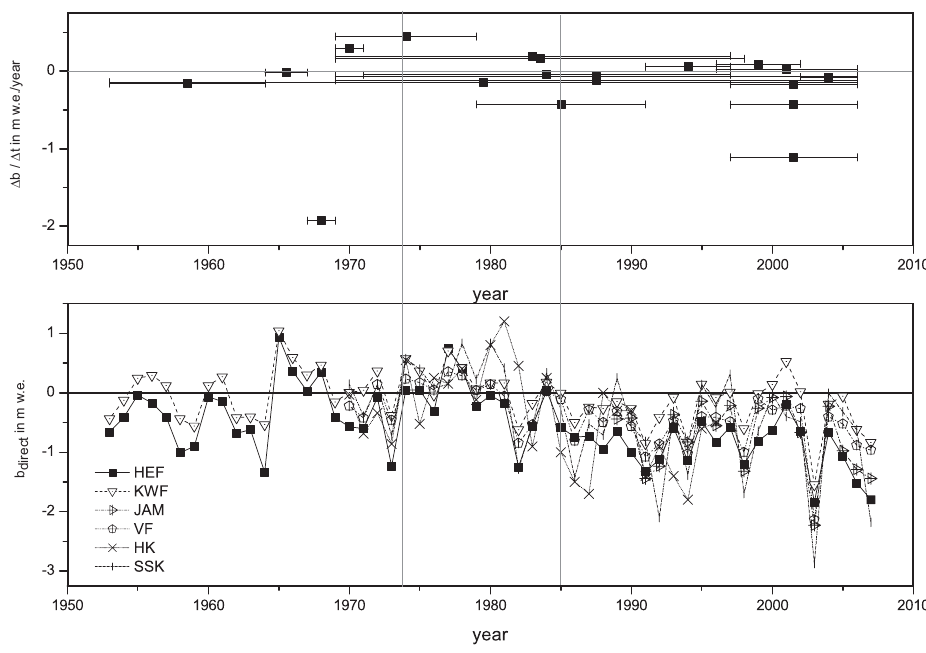
Fig. 9. Comparison of the difference between the geodetic and the direct mass balance per year 1b/1t and the direct specific mass balances b direct . The length of the period of the geodetic mass balance mean is indicated with